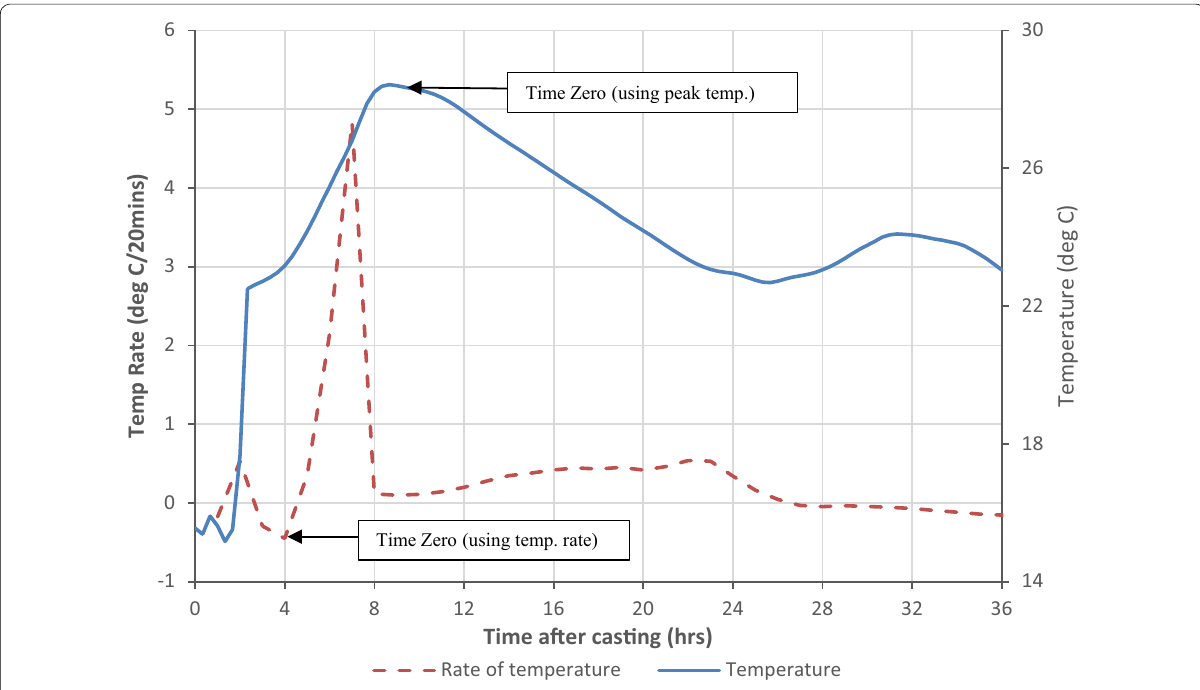
Fig. 8 Determination of Time Zero from measured temperature in the